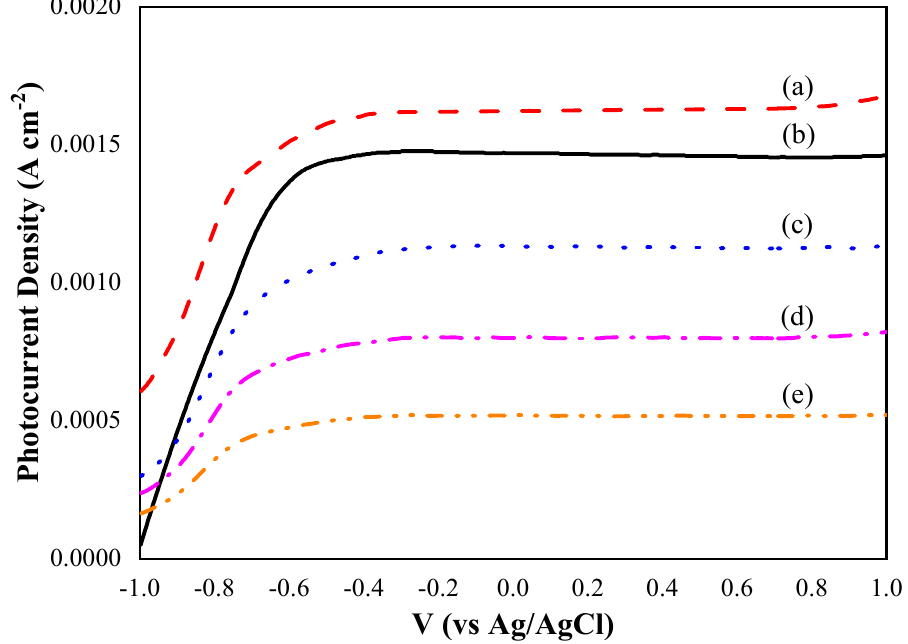
Figure 8. The j p -V characteristic curves of CdSe–TiO 2 nanotube thin films soaked at different temperatures of CdSe precursor: ( a ) 20 °C, ( b ) pure TiO 2 nanotubes thin film, ( c ) 40 °C, ( d ) 50 °C, and ( e ) 60 °C .